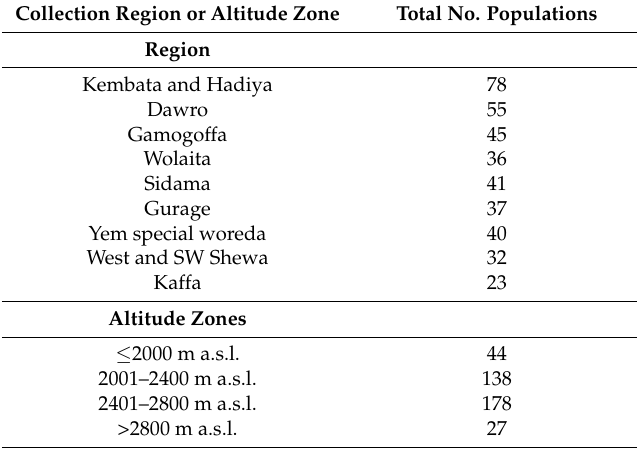
Table 8. Regions of origin, altitude, and numbers of landraces used for this study. m a.s.l. = meters above sea